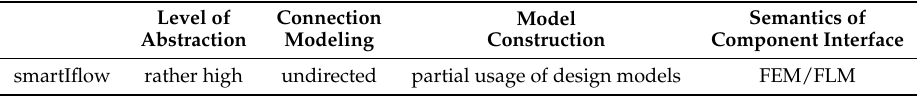
Table 2. Categorization of smartIflow according to criteria introduced in Section